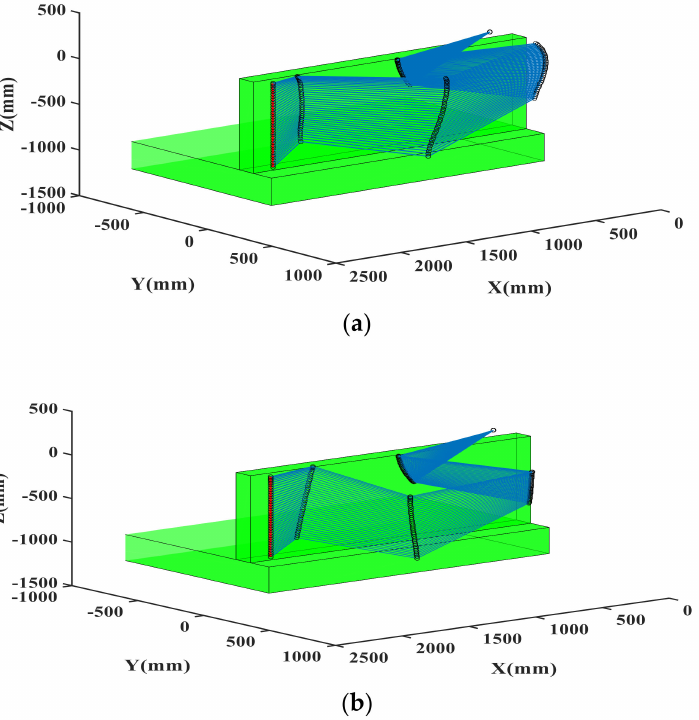
Figure 18. Schematic diagram of the collision-free trajectories of the manipulator. ( a ) Without optimization, ( b ) With